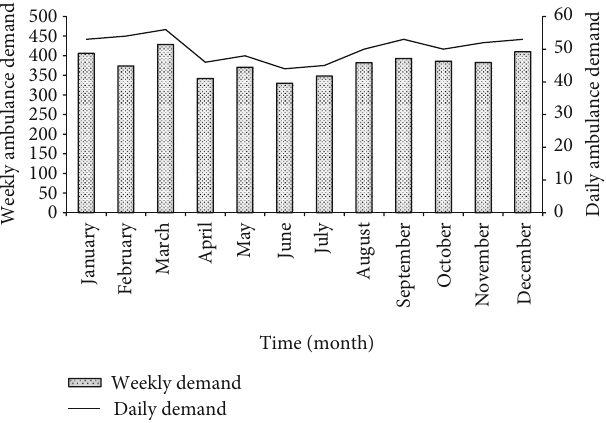
Figure 7: Projected weekly and daily number of ambulance calls for